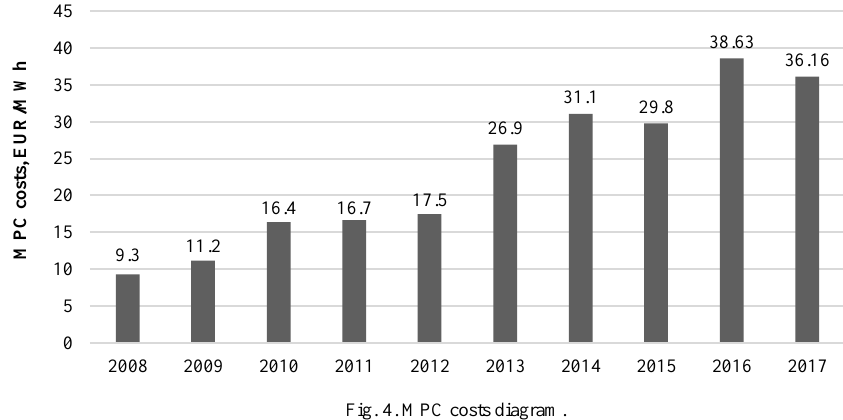
Fig. 4. MPC costs